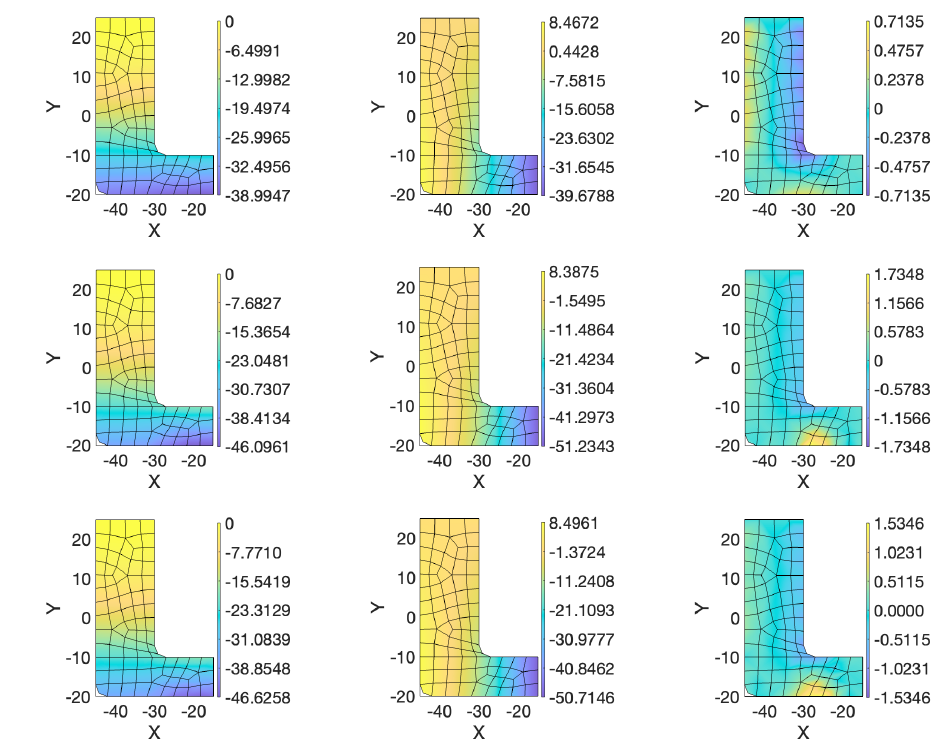
Figure 16. Top view of x ( left ), y ( center ) and z ( right ) components of the displacement field associated with the nominal solution ( top ); reference solution that takes into account the real damaged region ( middle ) and corrected model solution ( bottom ).